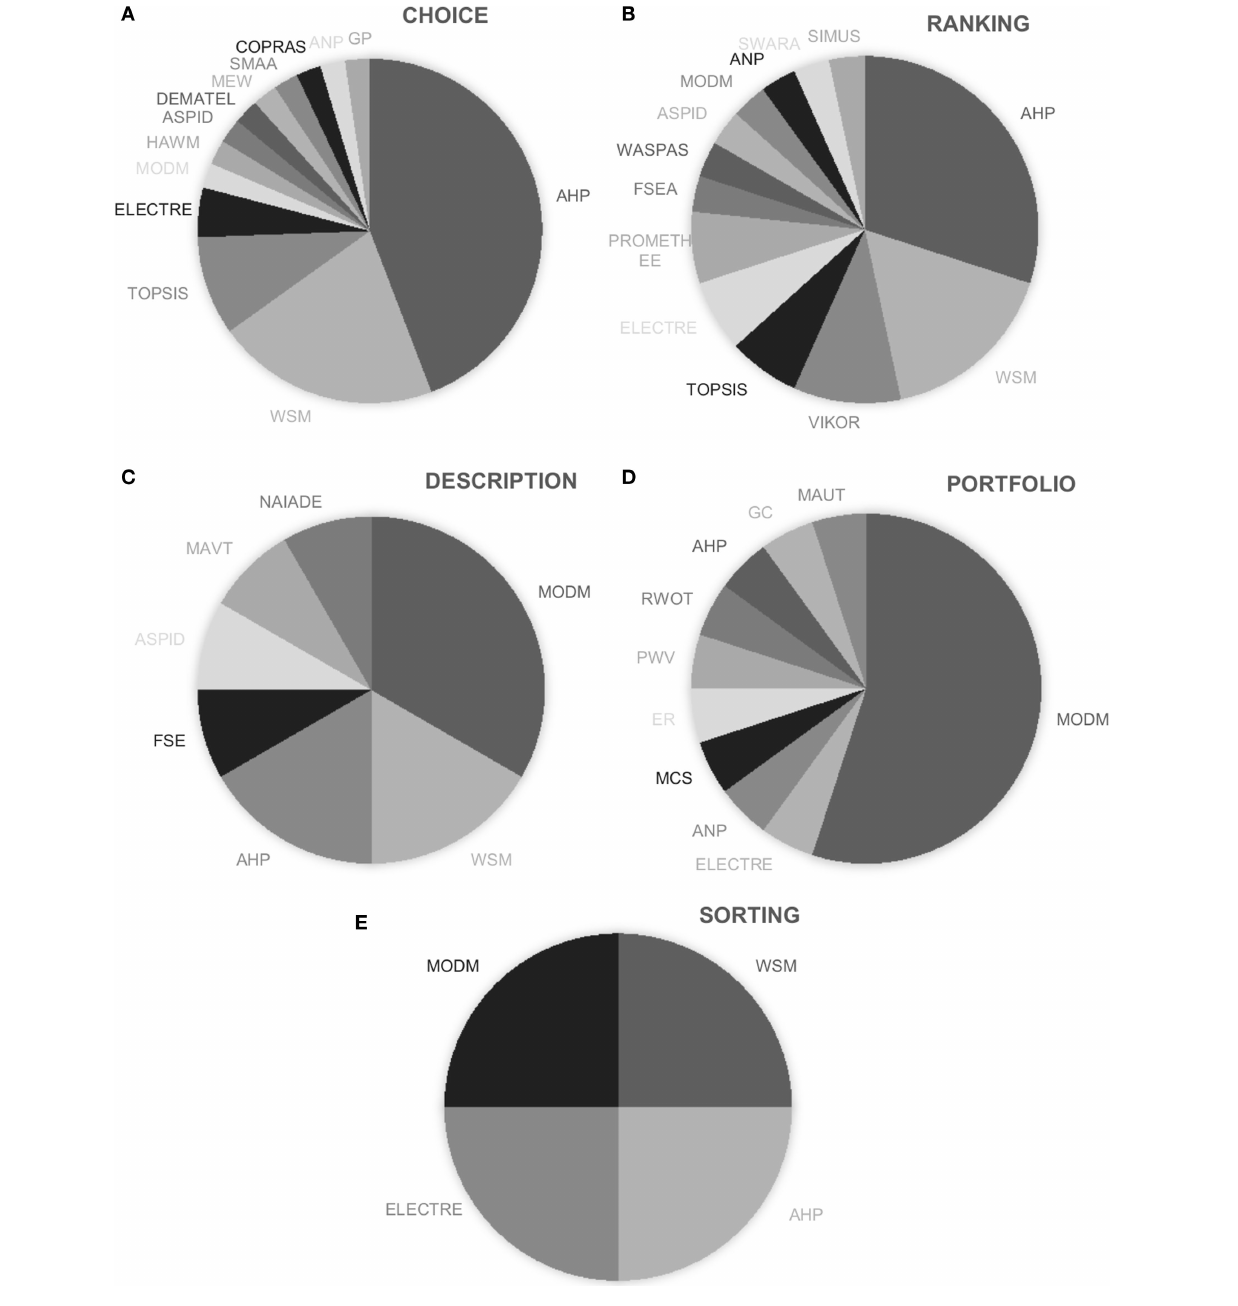
FiGURe 9 | Distribution of multicriteria decision analysis methods used per decision problematic as follows: (A) choice, (B) ranking, (C) description, (D) portfolio, (e) and sorting